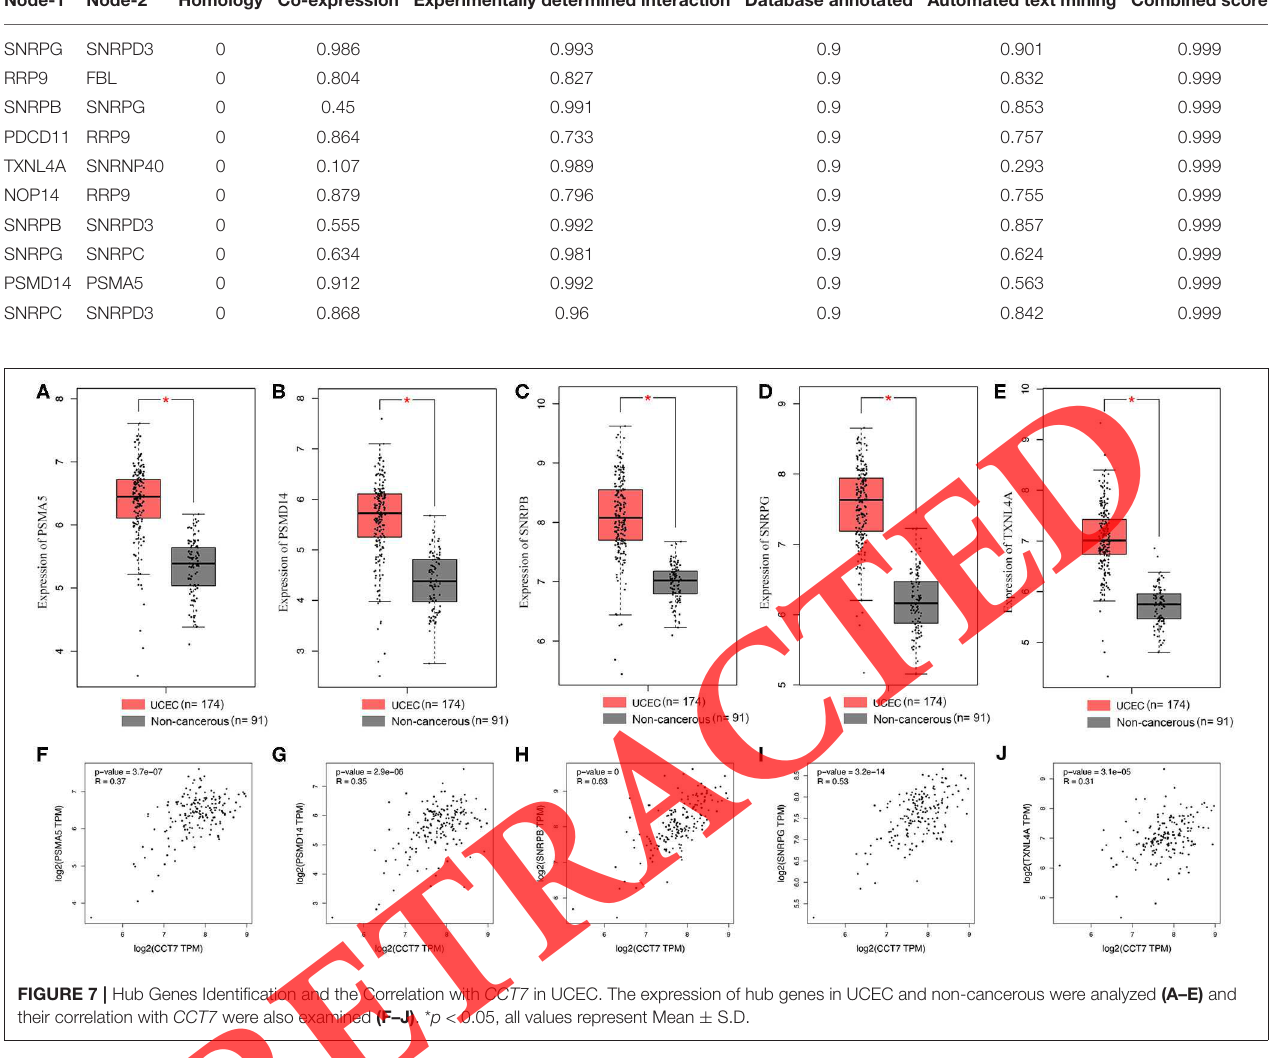
indicated that “RNA binding,” “Mitochondrion,” “Translation,” and “Spliceosome” were most significantly enriched potential pathways. In addition, five hub genes were analyzed from the PPI network, PSMA5, PSMD14, SNRPB, SNRPG, and TXNL4